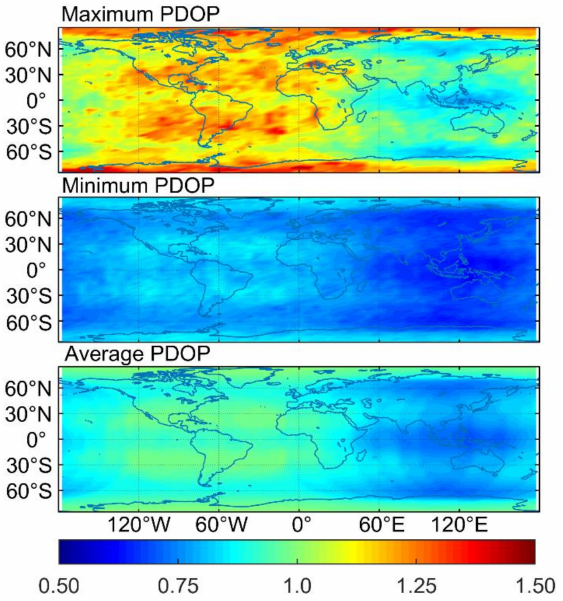
Figure 2. Global maps of maximum, minimum and average PDOP values for five-system combination on DOY 122 of